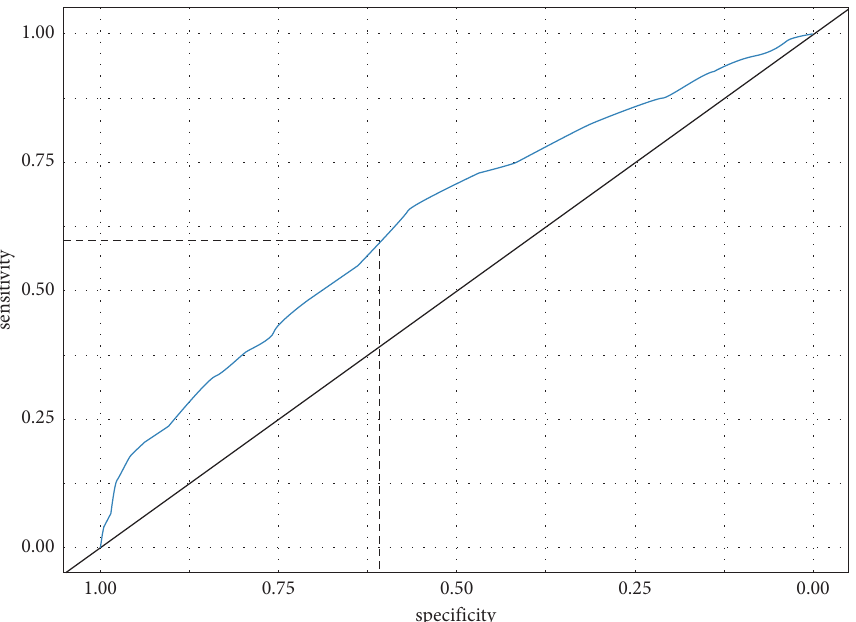
Figure 1: ROC curve for FFPG � 92mg/dl after logistic regression versus diagnosis of GDM (AUC � 0.64; sensitivity � 59.57% (95% CI: 59.37%—59.75); specificity � 60.71 (95% CI: 60.52%–60.89%)). Table 1: Clinical and metabolic parameters of the study sample, grouped by NGT versus GDM, and by FFPG ( < 92 mg/dl or ≥